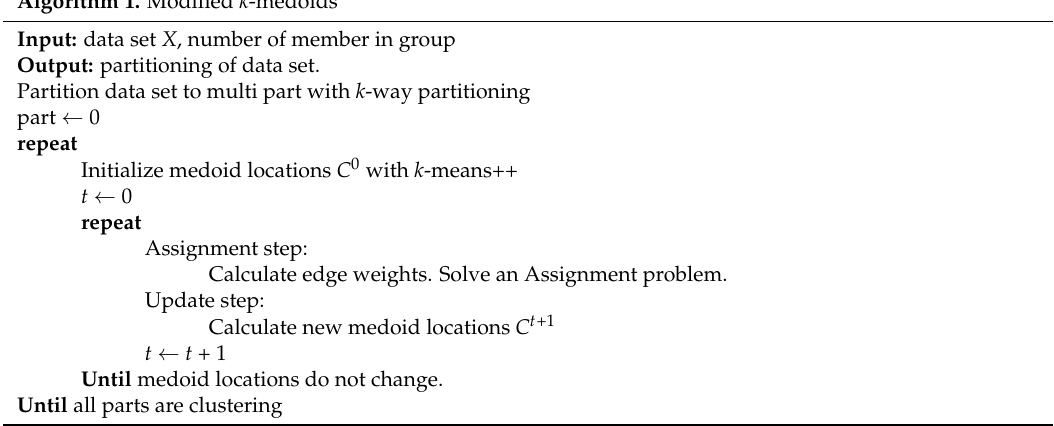
Figure 3 . Minimum distance calculation with balanced clusters (adapted from [26] ) . Figure 3. Minimum distance calculation with balanced clusters (adapted from [26]). Algorithm 1. Modified k -medoids Algorithm 1. Modified k